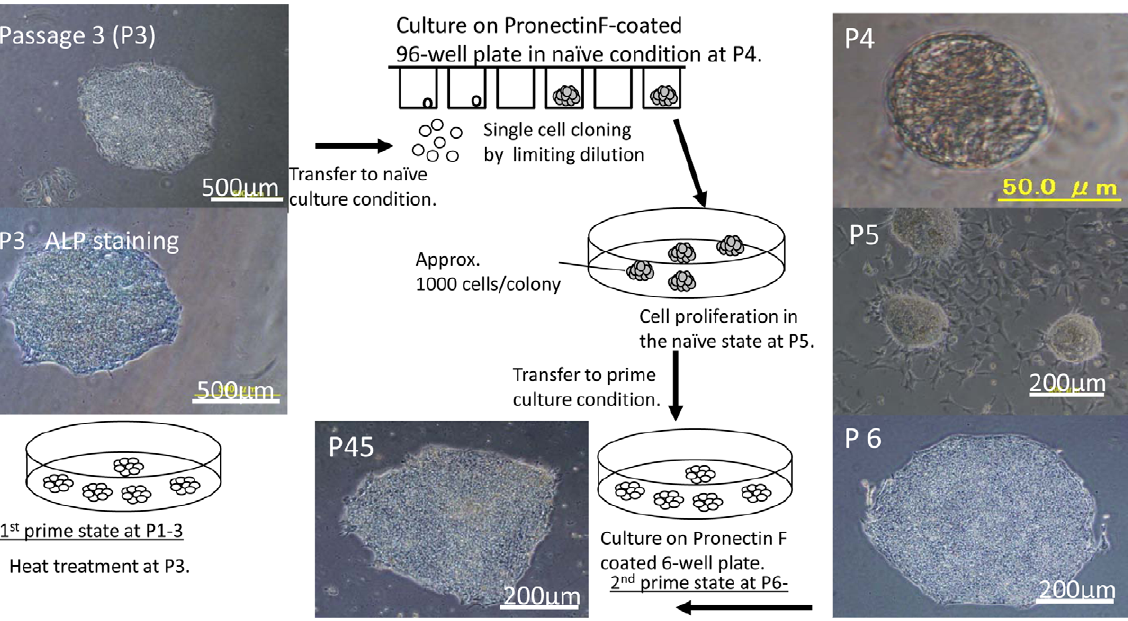
Figure 3. Generation of reprogrammed cell clone from a single cell via the naı¨ve state. Human ES cell-like colonies (first prime state) were picked up at day 24 and cultured on Pronectin F-coated dishes. The colonies were subjected to heat treatment (38 u C, three days) at passage three (P3). Light microscopic image and ALP staining at P3 are shown in upper and lower panels, respectively. Colonies emerged from single cells in Pronectin F-coated 96-well plates under naı¨ve conditions at P4, dome-shaped colonies at P5 under naı¨ve conditions, ES cell-like colonies (second primed) cultured under primed culture conditions at P6 or long-term passaged clone (PFX # 9) at P45 are shown.